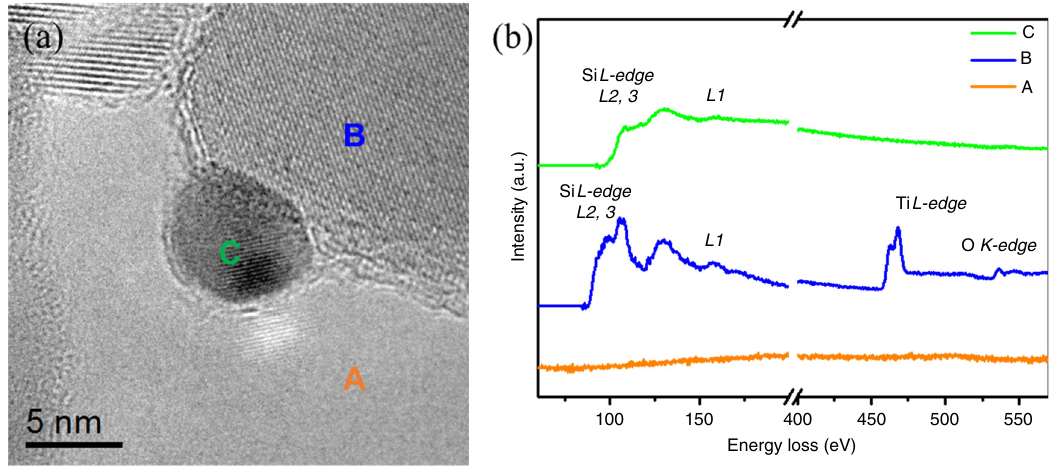
Fig. 3 The EELS analysis of Au@SiO2/Ti-800. a TEM image; b EELS